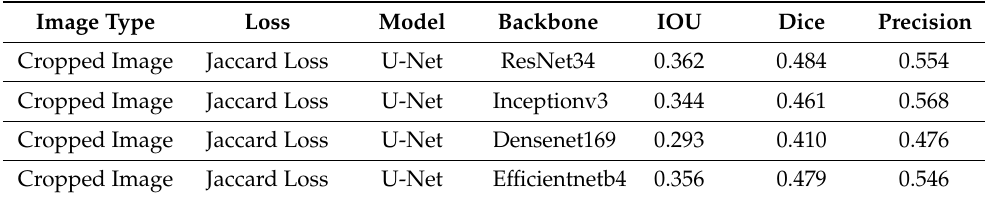
Table 2. Training and testing on B-Scans using (4) model backbones for the cropped image type using Jaccard loss.